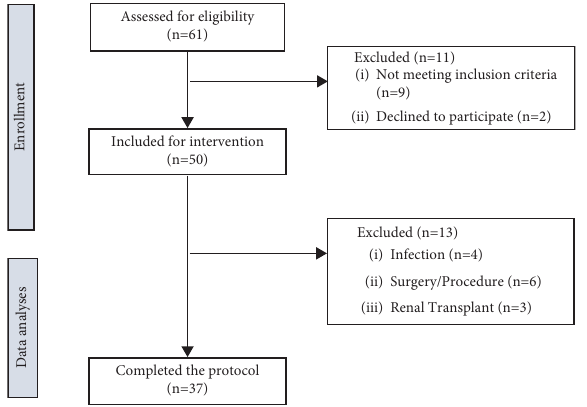
Figure 1: Flow diagram of study participants.